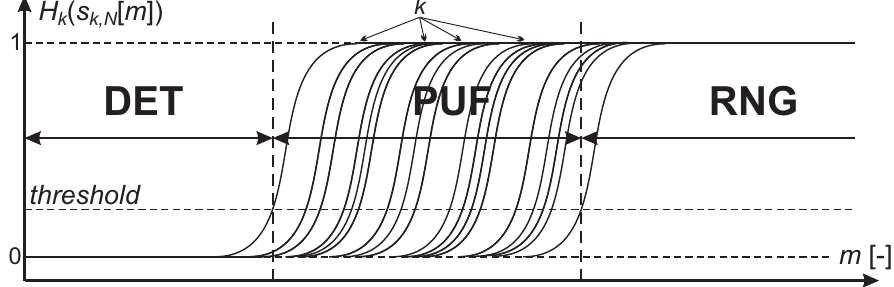
Figure 4. Model of a time-based window for PUF